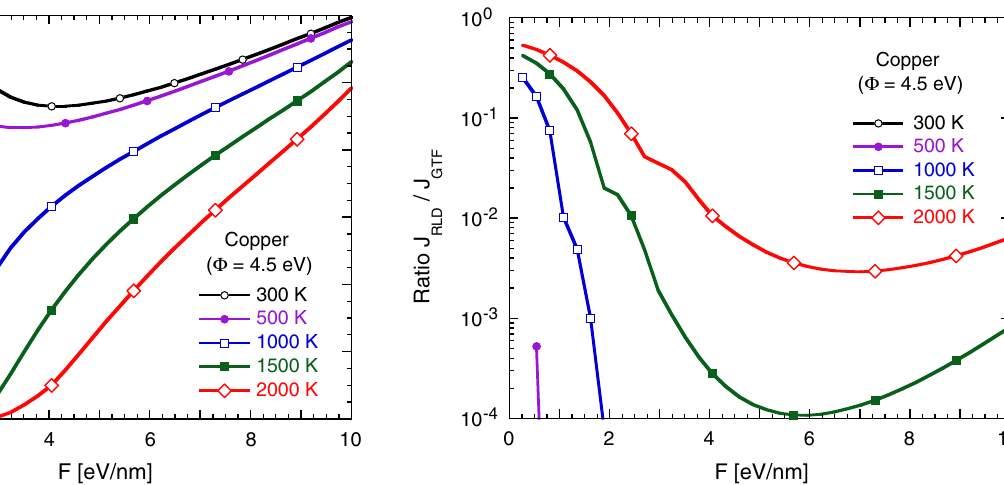
FIG. 18. (Color) Performance of the Fowler-Nordheim (FN) equation using the quadratic elliptical function approximations to the general thermal-field (GTF) equation. The FN equation in this approximation is temperature